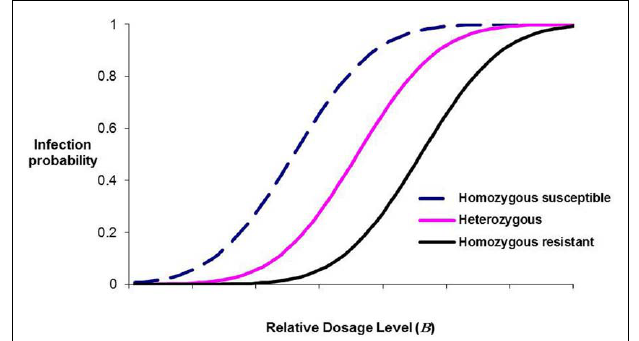
FIGURE 1 | Infection probability as a function of dosage level for three hypothetical major-gene genotypes, illustrating how the inferred mode of resistance will change as dosage level changes.